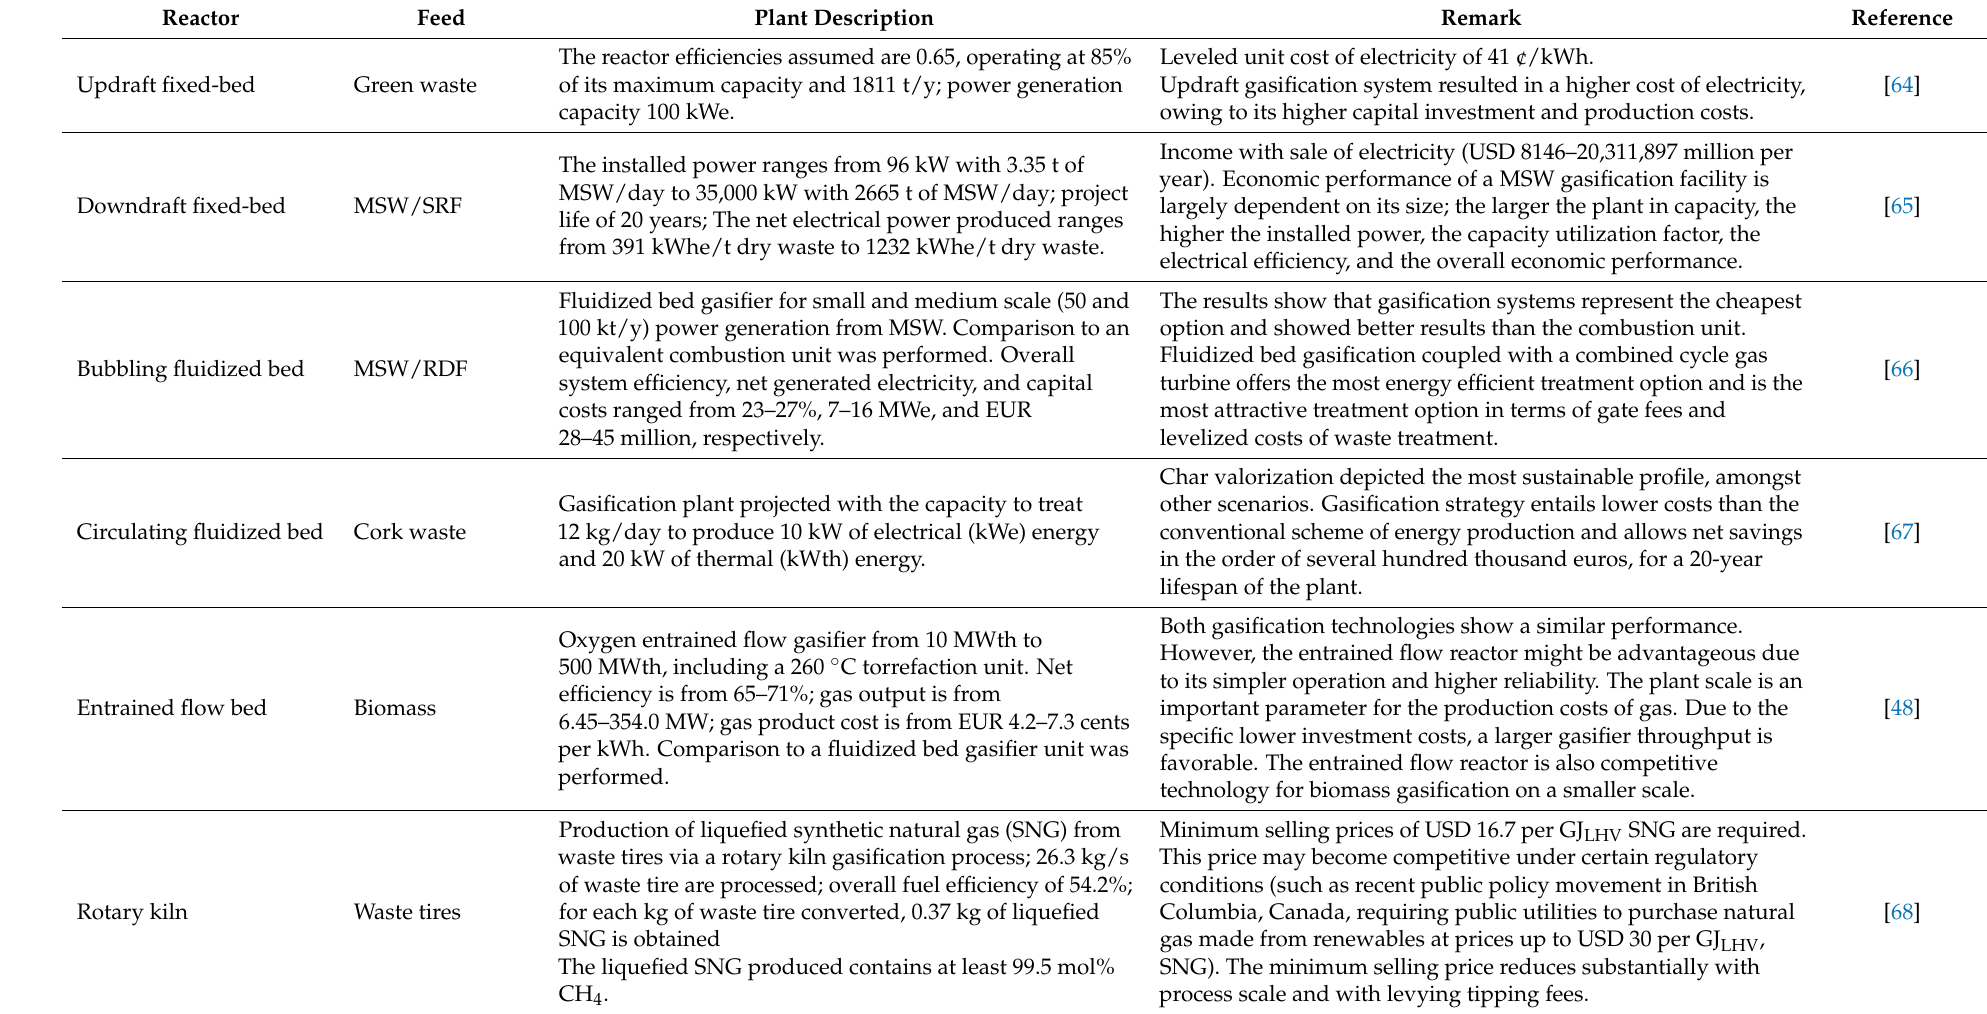
Table 3. Overview of techno-economic studies about gasification